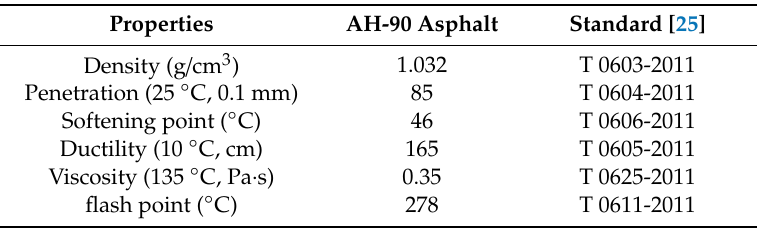
Table 1. Basic properties of asphalt.